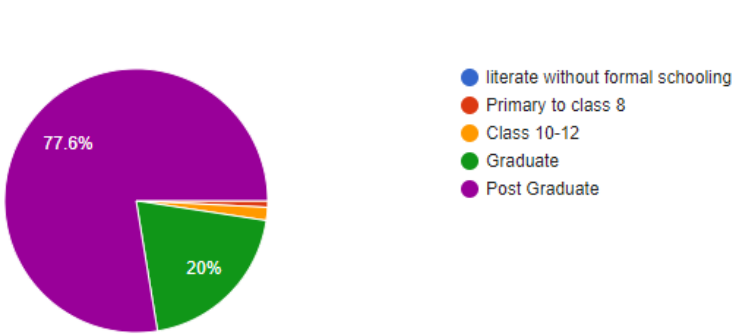
Figure 3: Age (Source: Online survey)